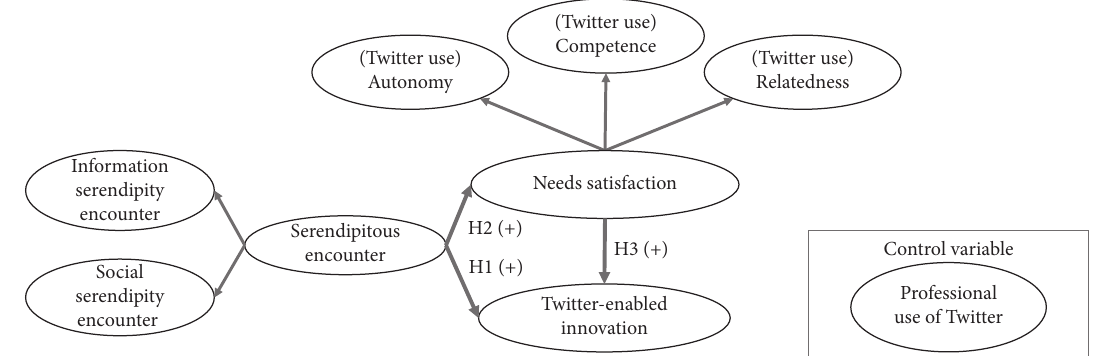
Figure 1: Serendipity model in the professional use of